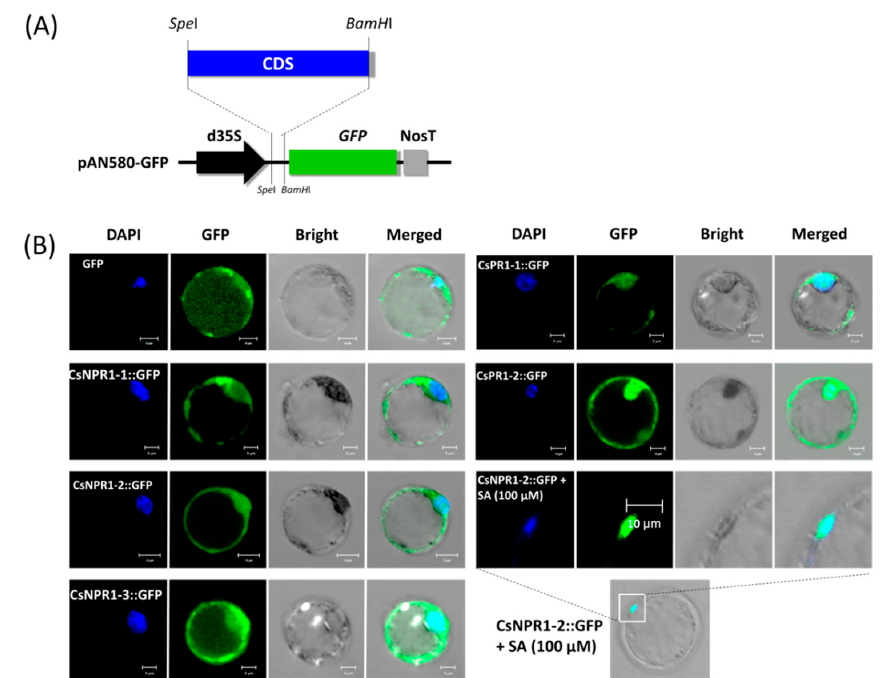
Figure 7. Transient expression of CsNPR1-2 in Cymbidium protoplasts. ( A ) Vectors used for transient expression were obtained by cloning the full-length CDSs into the vector PAN580-GFP; ( B ) Plasmid DNA expressing GFP and fusion protein were transfected into Cymbidium protoplasts, and the fluorescence was detected under an LSM 710 confocal laser microscope with a blue excitation block at 12-18 h post-transfection; In the presence of SA (100 μ M), fusion protein CsNPR1-2::GFP was co-localized with the DAPI signal, indicating the nuclear localization of CsNPR1-2 protein.